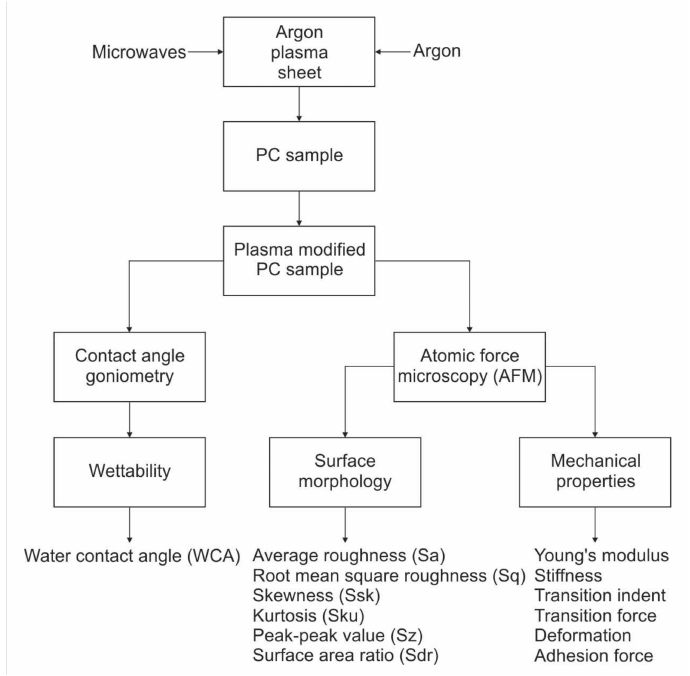
Figure 1. Diagram of the investigation